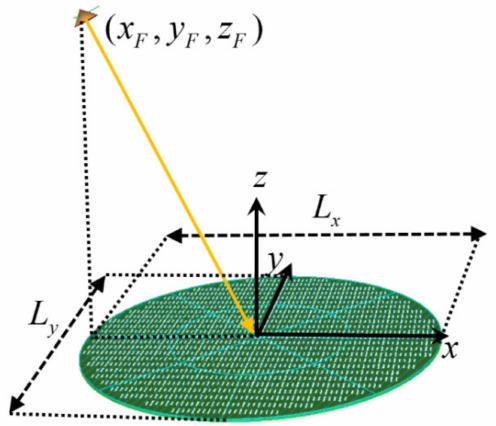
Figure 3. Shaped beam reflectarray made of three coplanar parallel